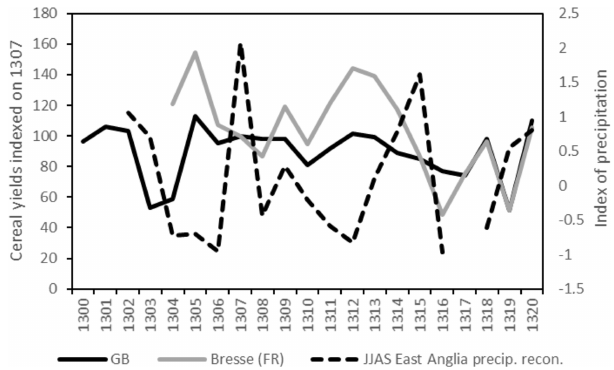
Figure 5. Mean wheat and wine yields in the region of Bresse (FR), 1300–1320.